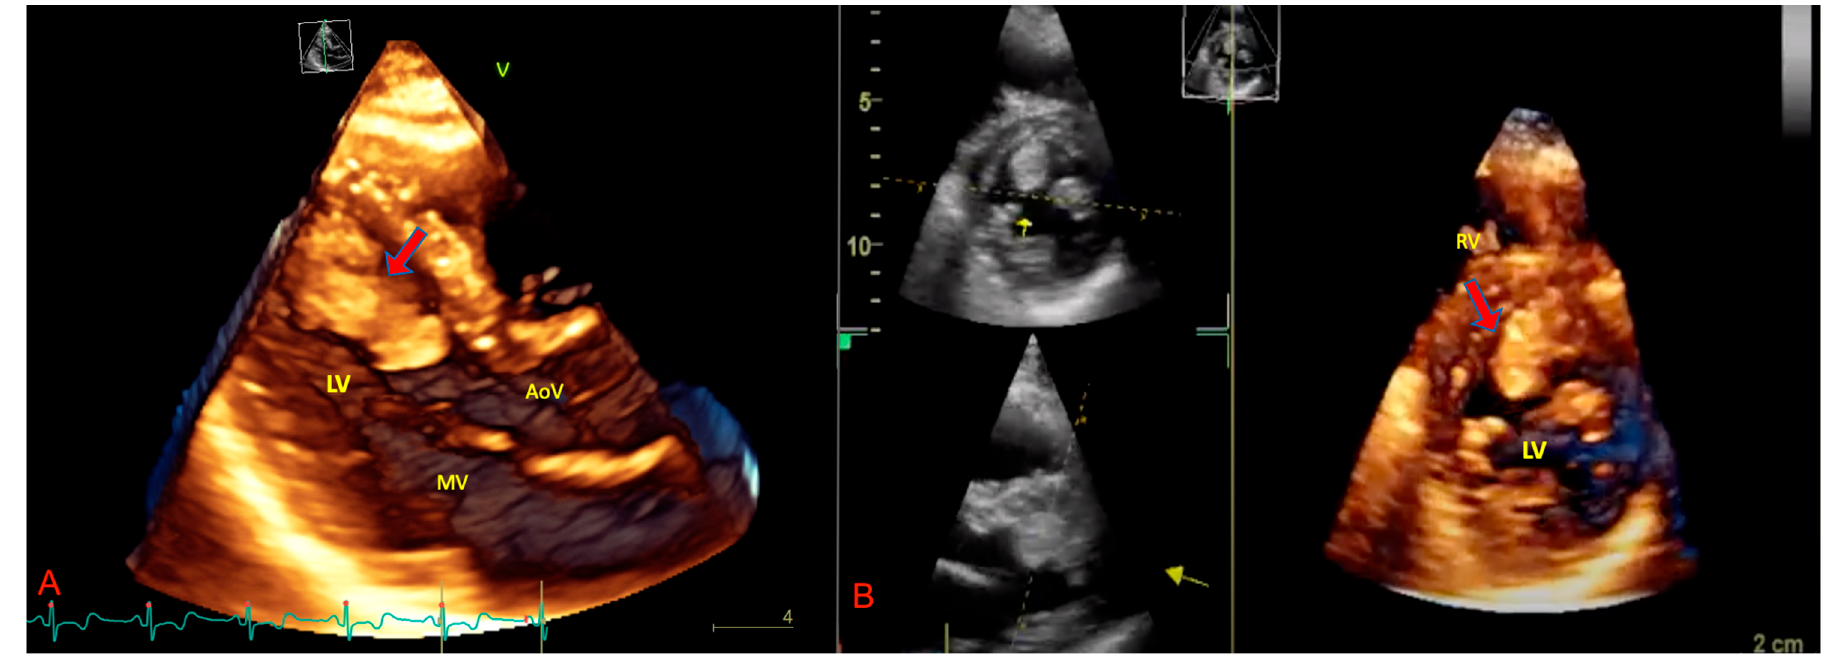
Figure 3. Three-dimensional transthoracic echocardiography in apical three-chamber view ( A ) and parasternal short-axis view ( B ) showing intracardiac sarcoma attached to left ventricular apex. The arrows (red and yellow) indicate the cancer mass. AoV: aortic valve; LV: left ventricle; MV: mitral valve; RV: right ventricle.